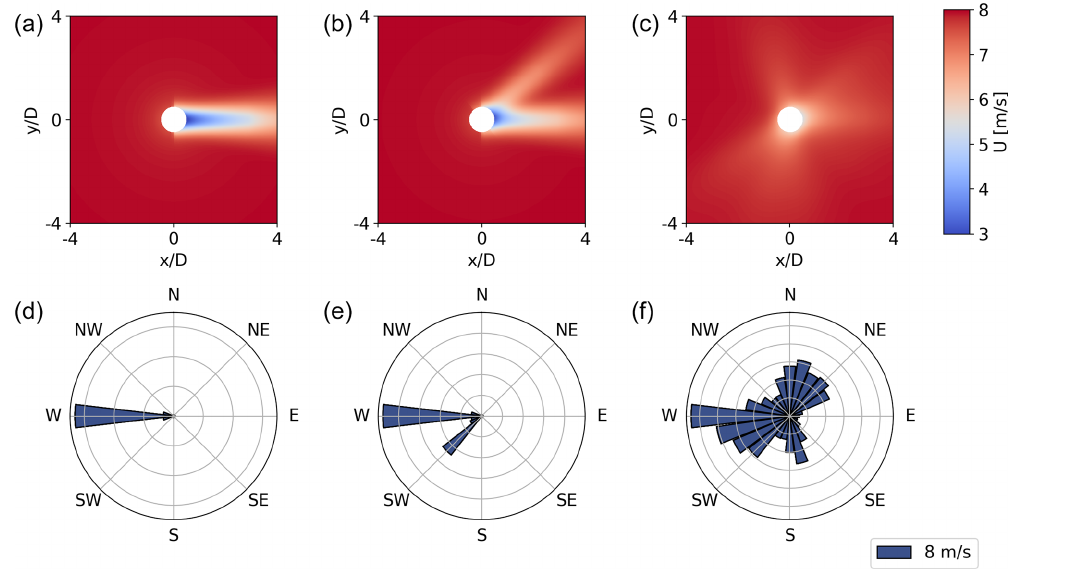
Figure 1. (a, d) Velocity contour plot of flow through a wind turbine for a single wind direction. (b, e) Averaging effect of two wind directions. (c, f) The annually averaged velocity flow field. Note that the wind roses (d–f) display the frequency of each wind direction with a constant wind speed of 8ms − 1 for every